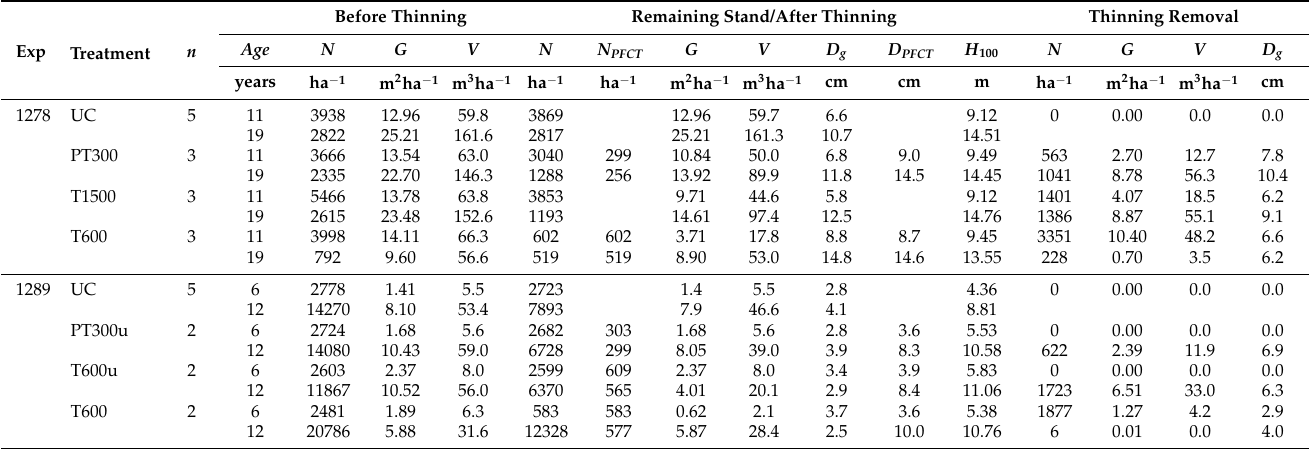
Table 3. Stand values for stem number ( N , including ingrowth), stand basal area ( G ), stand volume ( V ), quadratic mean diameter ( D g ), stand top height ( H 100 , the average height of the 100 thickest trees per ha), number of pre-selected potential future crop trees ( N PFCT ) and arithmetic mean diameter of potential future crop trees ( D PFCT ) at initiation of the experiment and at the end of the observation period for experiments 1278 (age: 11–19 years) and 1289 (age: 6–12 years). The table includes unadjusted mean values per treatment type ( n = number of plots). Legend: PT300u and T600u refer to so far unthinned